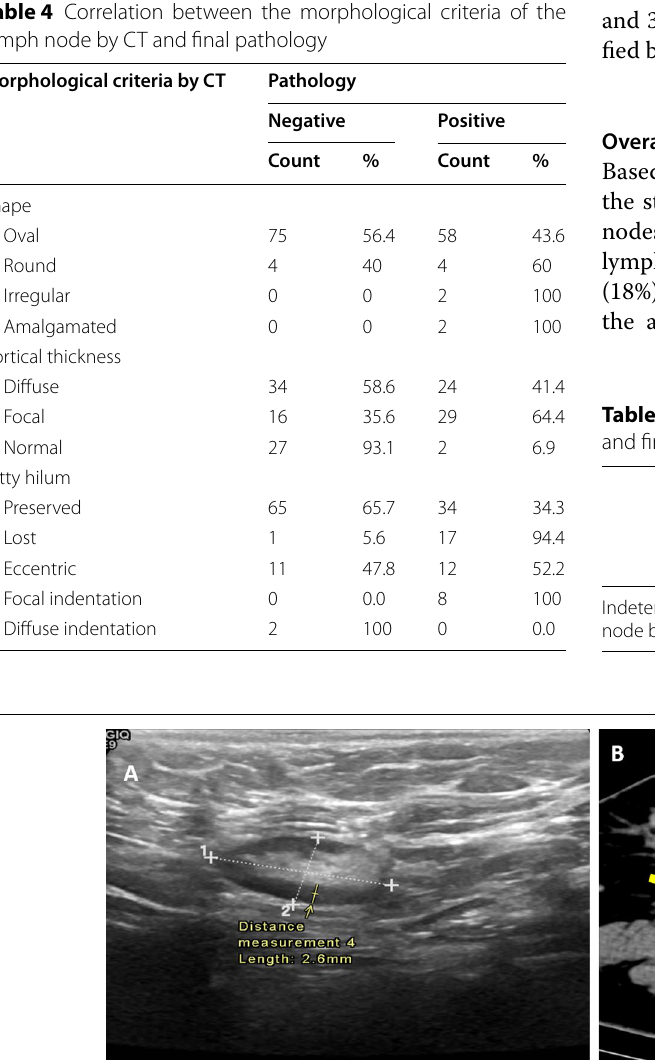
Fig. 3 A 51‑year‑old female with right pathologically proven non‑metastatic axillary lymph node. A Axillary ultrasound image shows a non‑specific LN with average cortical thickness and preserved fatty hilum (true negative). B CT image shows an indeterminate LN with diffuse cortical thickness and central fatty hilum (false positive). LN; Lymph node, CT; computed tomography